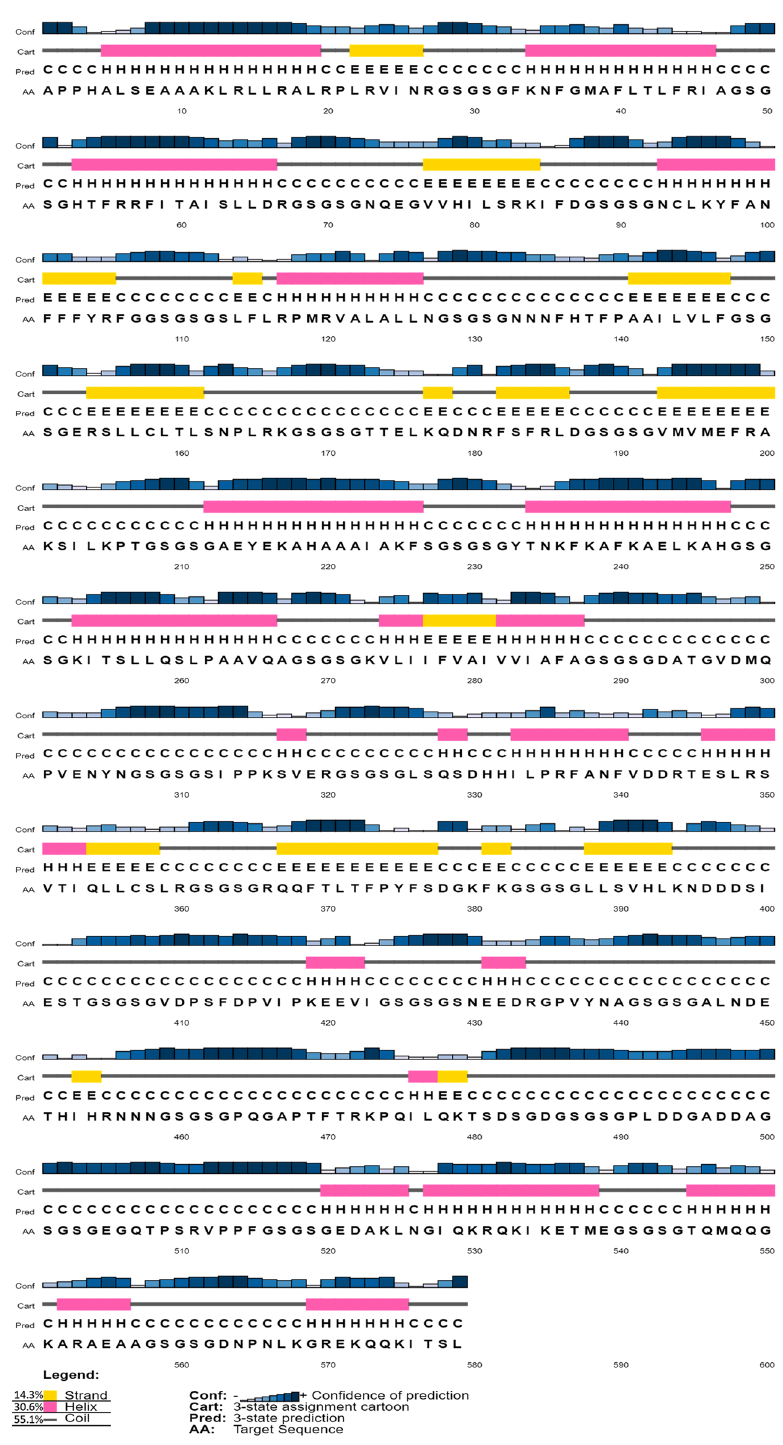
Figure 4. The vaccine secondary structure as estimated by PSIPRED 4.0. The predicted 2D structure contains coils (55.1%), α-sheets (30.6%) and β-strands